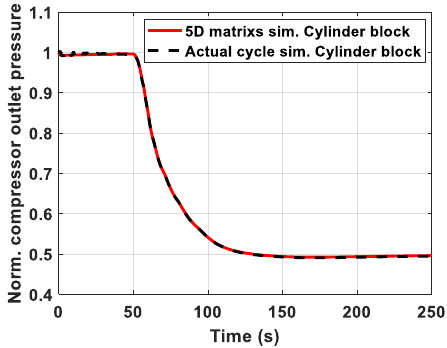
Figure 24. Compressor outlet pressure time history.